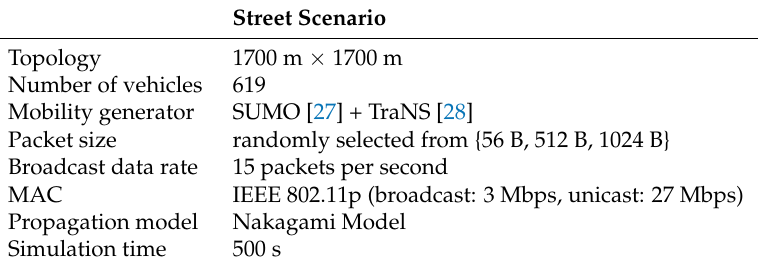
Table 3. Simulation Environment.